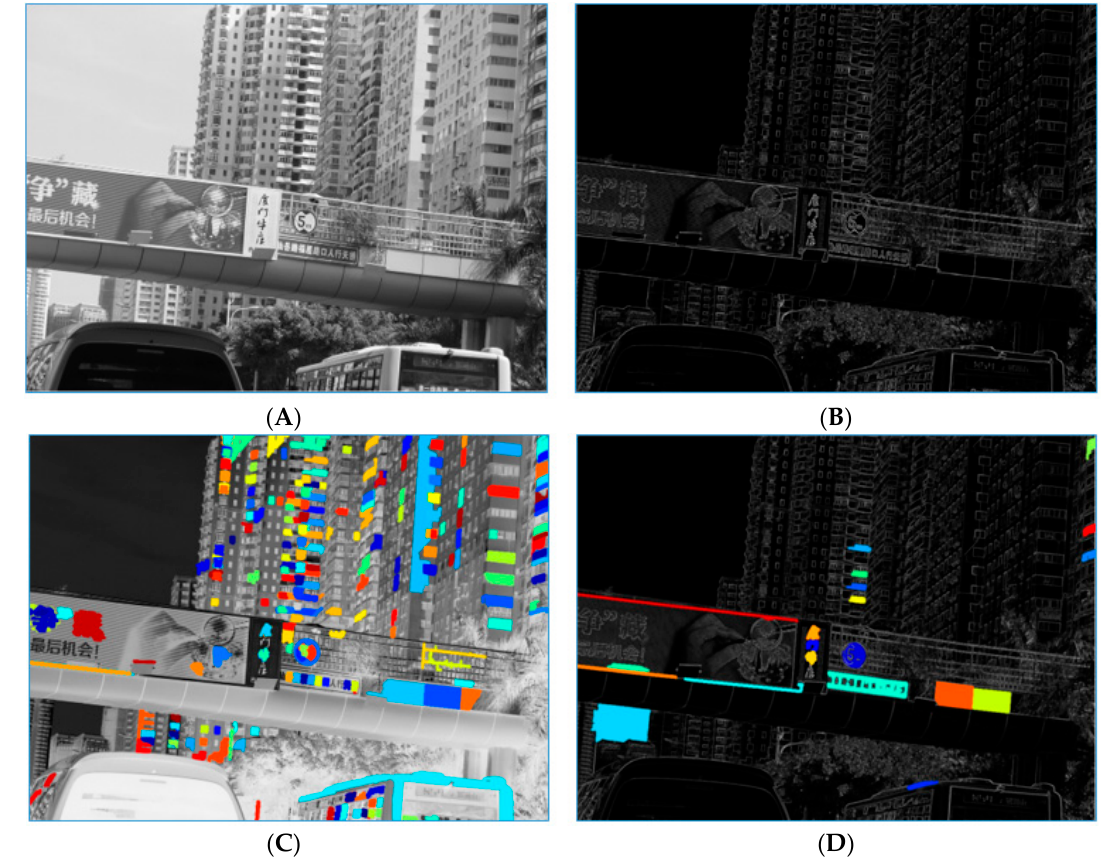
Figure 5. The process of finding the highly possible regions. ( A ): grayscale image, ( B ): feature map by synthesis the eight SGW feature maps, ( C ): maximally stable extremal regions (MSERs) on the frame (A), ( D ): MSERs on the frame (C).